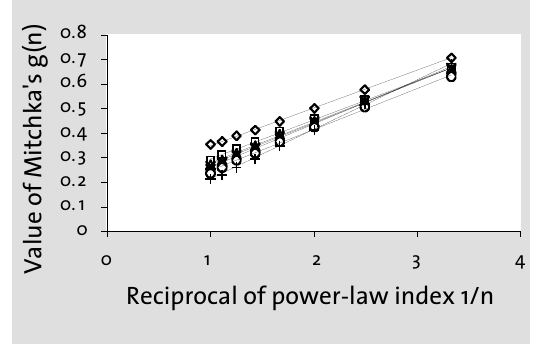
Figure 11 (left): The value of Mitschka’s shear rate factor versus the reciprocal of the power-law index, showing the linear relationship fits to the points. Figure 12 (right): Simplified form of the stress/couple for the RV spindles 2 – 6 ( s = 1.2 x 10(m-5)/3 T ) and the LV spindles 1 – 4 ( s = 1.2 x 10(m-3)/1.5 T ), where m is the spindle number.